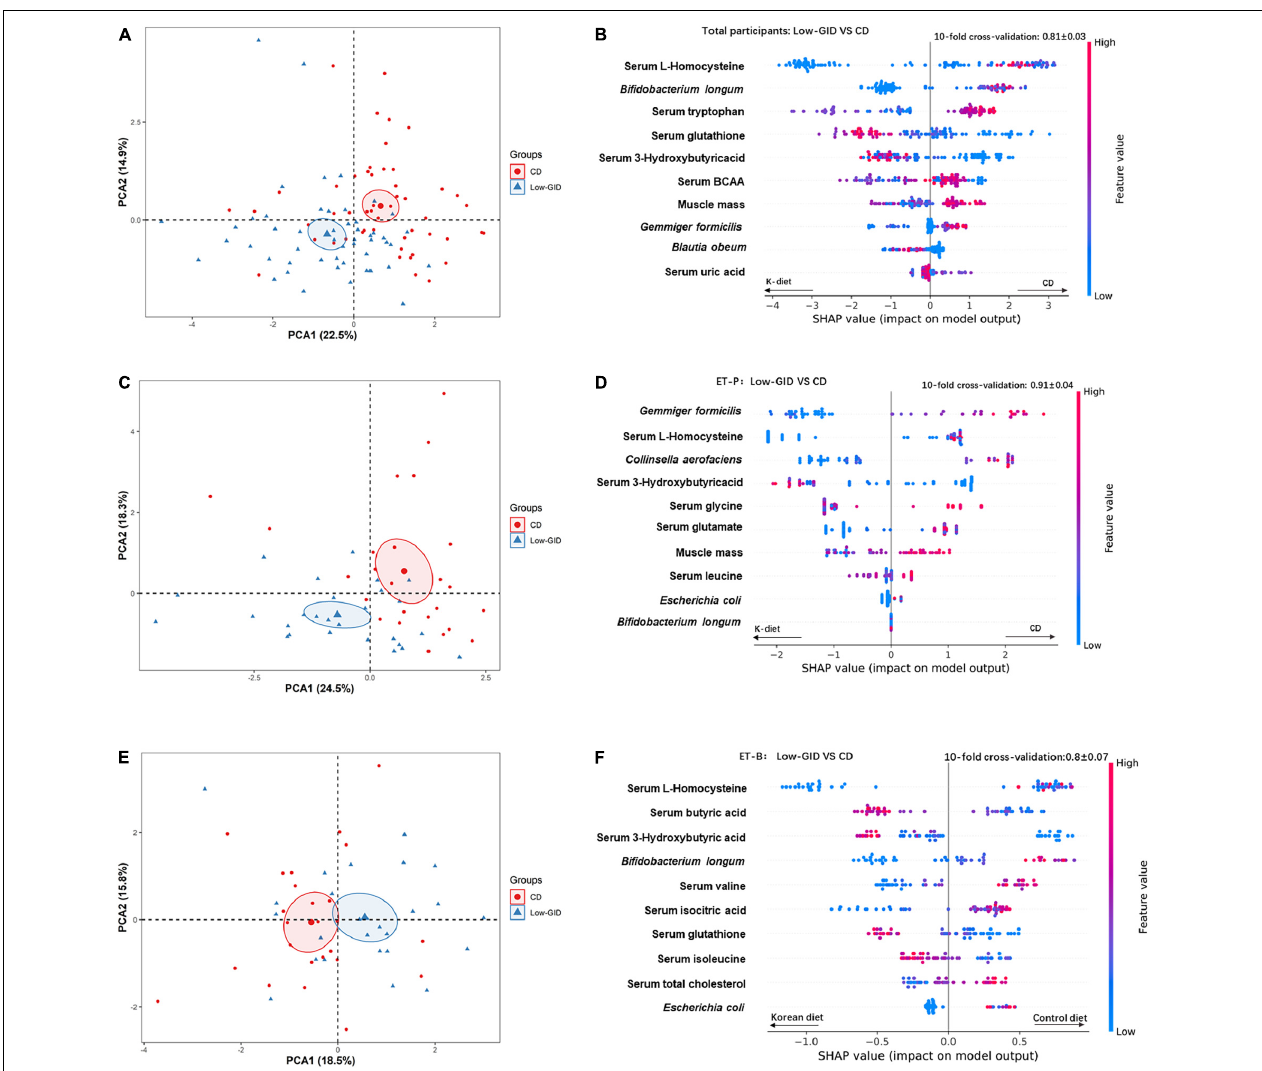
FIGURE 3 | XGBoost classification model variable interpretation of Korean traditional balanced diet (Low-GID) and control diet (CD) based on the overall SHAP, Prevotella , and Bacteroides clusters. The 10-fold cross-validation is expressed in terms of mean ± SD. In the figure, the left side of the scattered dots to the 0-scale line is the Korean traditional diet classification, and the right side is the control diet classification. The height of the color represents the size of the variable. (A) PCA analysis of CD and Low-GID in the overall cohort. (B) XGBoost categorical variable interpretation, in the overall cohort. (C) PCA analysis of CD and Low-GID in the Prevotella enterotype cohort. (D) XGBoost categorical variable interpretation, in the Prevotella intestinal cohort. (E) PCA analysis of CD and Low-GID in the Bacteriodes enterotype cohort. (F) XGBoost categorical variable interpretation, in the Bacteroides intestinal cohort. BCAA, branched-chain amino acid; TG,